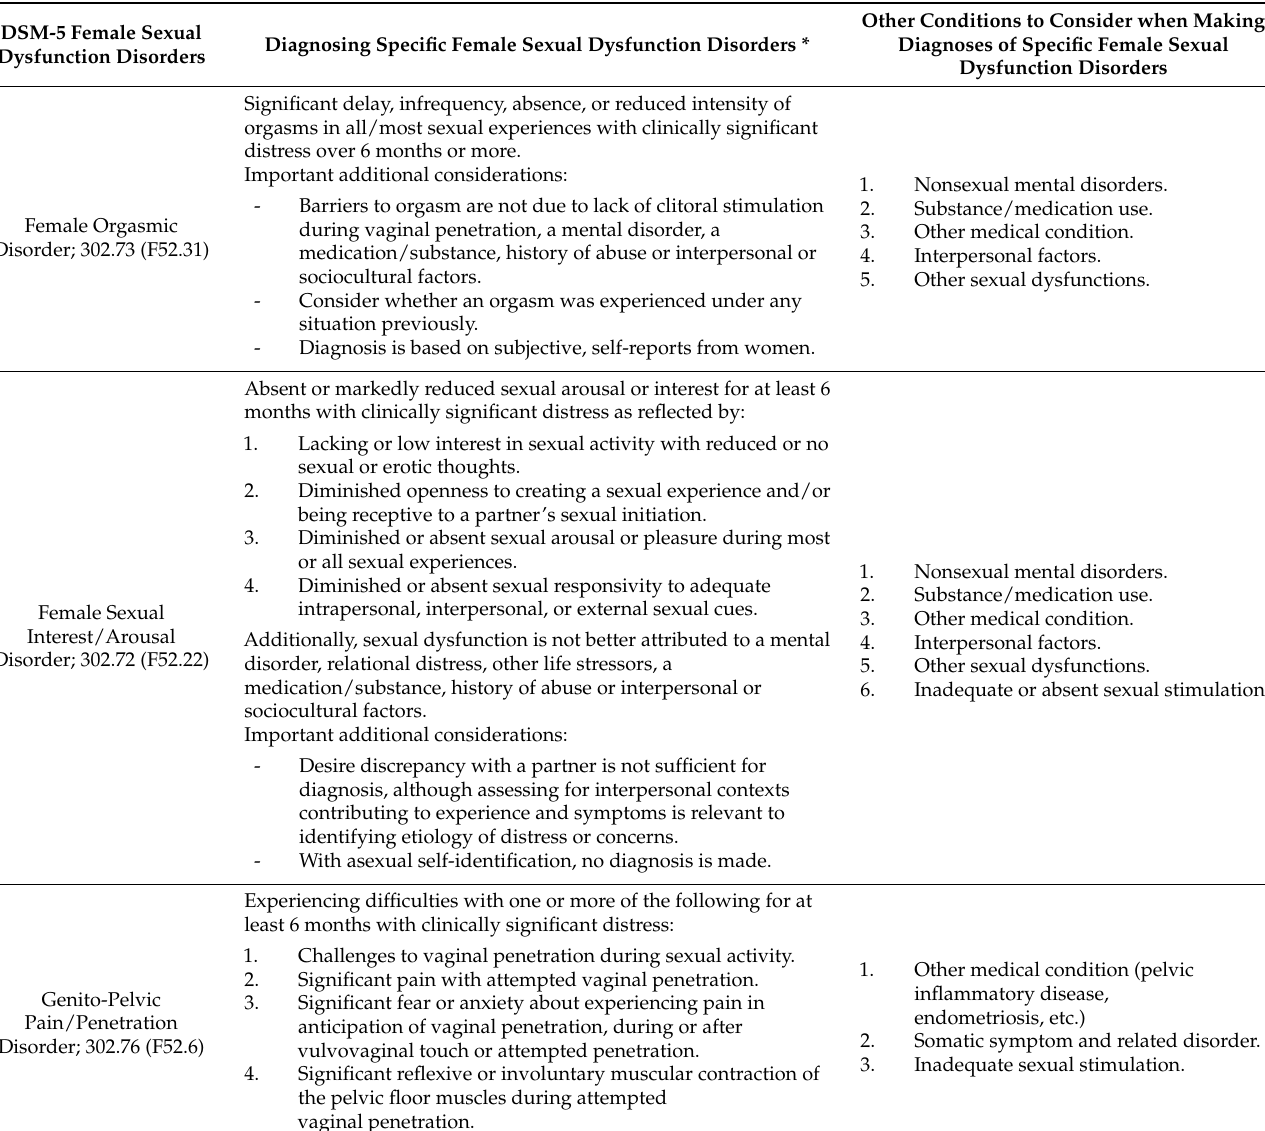
Table 1. Diagnostic and Statistical Manual of Mental Disorders (DSM-5) Female Sexual Dysfunction